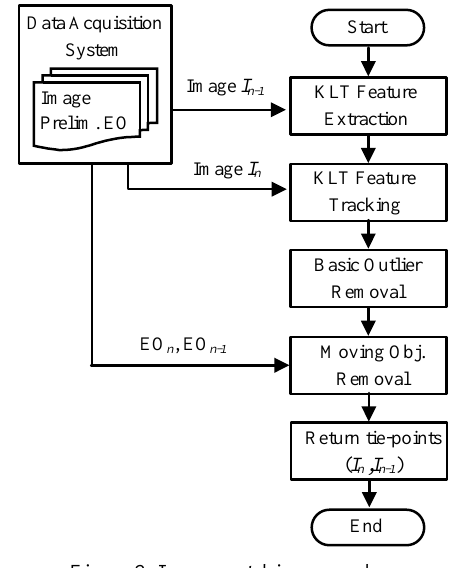
Figure 2. Image matching procedure